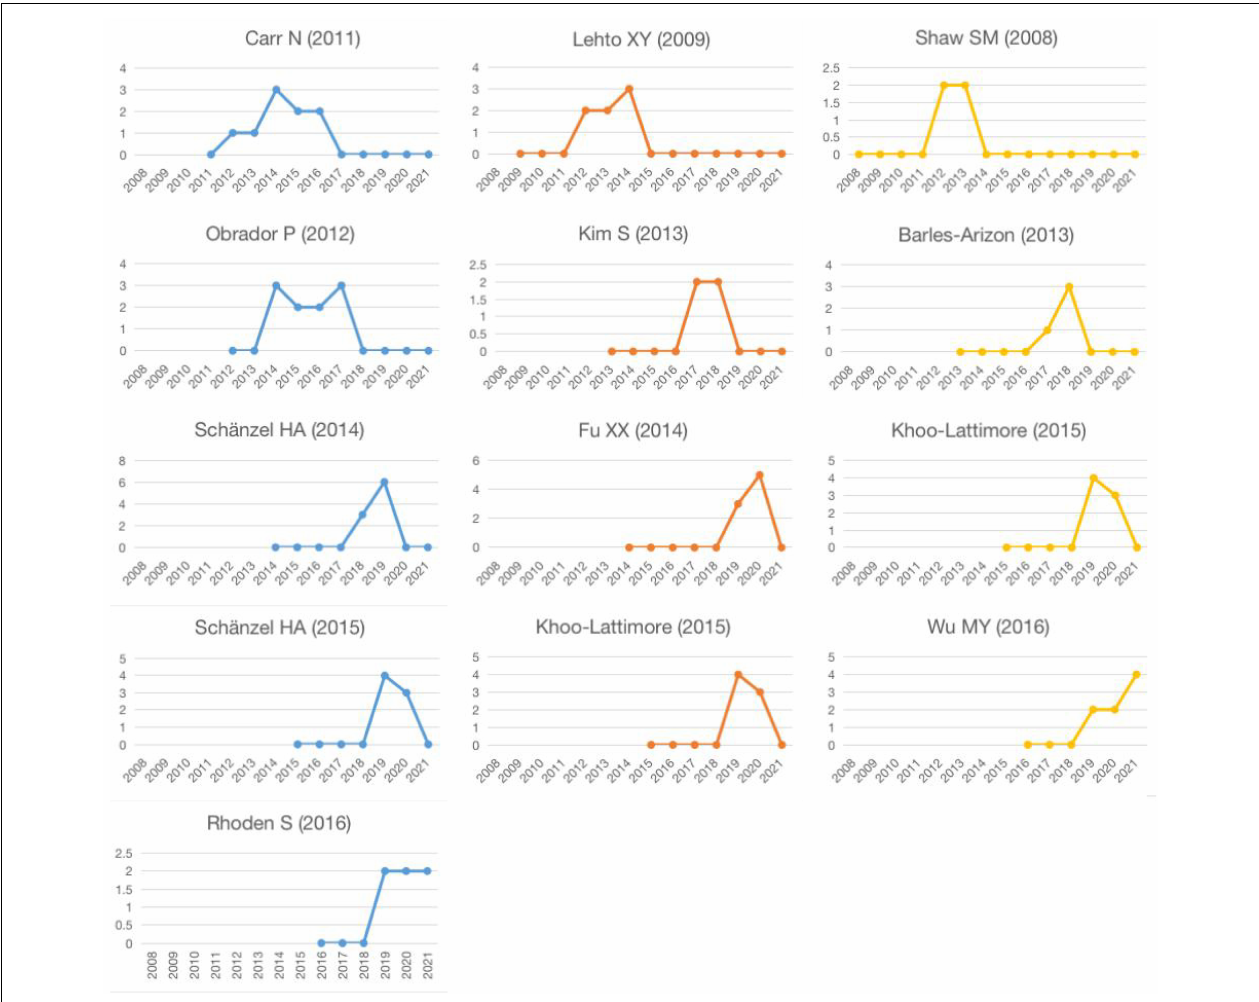
FIGURE 8 | The annual citation count for top 13 references from publication year to